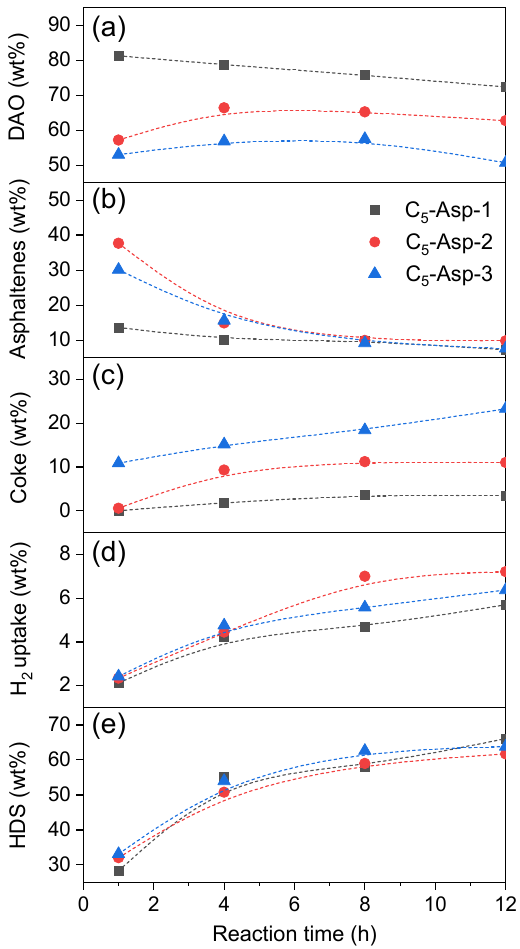
Figure 7. Yields for ( a ) DAO, ( b ) remaining asphaltenes, ( c ) coke, ( d ) H 2 consumption, and ( e ) hydrodesulfurization (HDS) during catalytic hydrocracking of asphaltene subfractions in the semi-batch system. Reaction conditions: T = 410 °C, P H2 = 110 bar, and 1000 wppm of Mo from Mo-octoate.